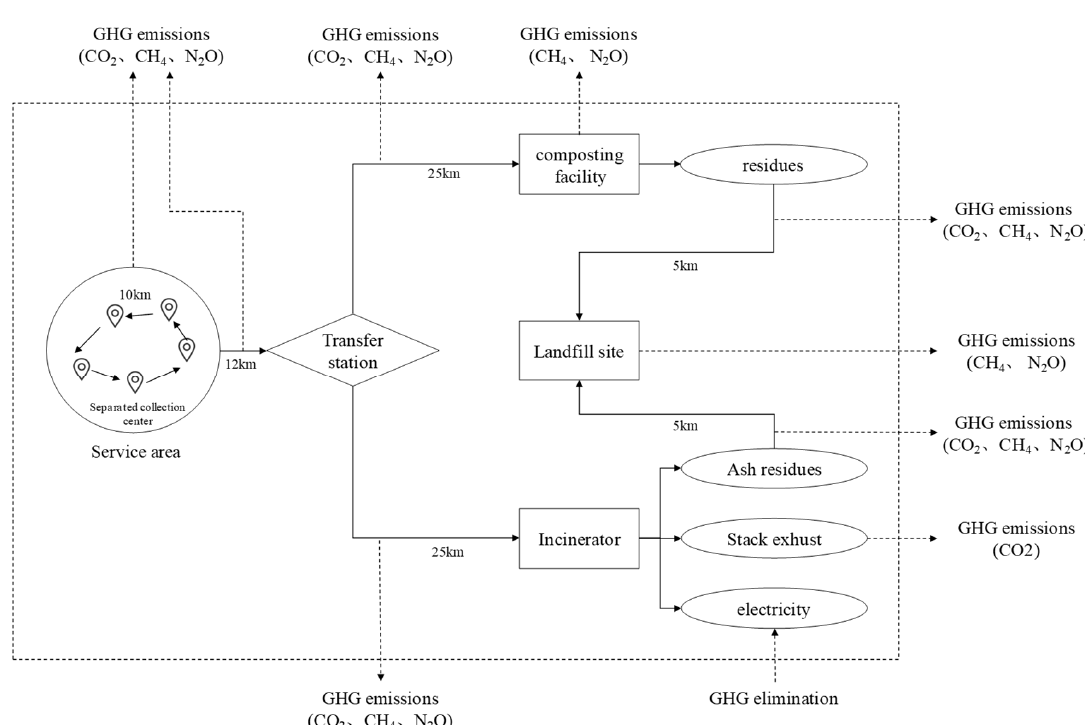
Figure 3. GHG emissions evaluation boundary in Scenario 2.